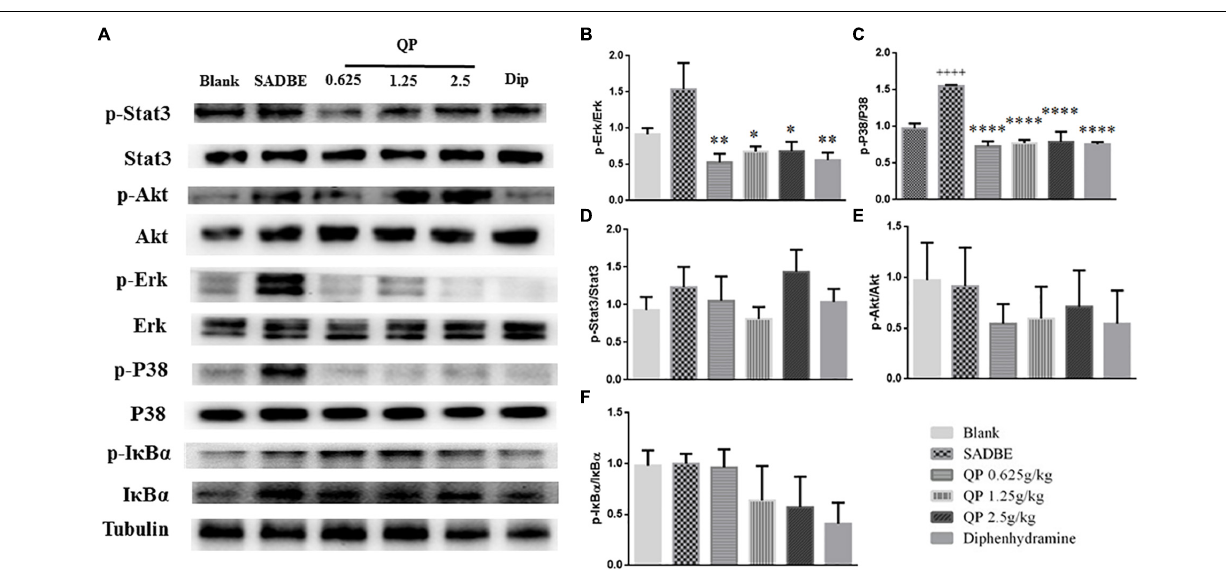
FIGURE 6 | QP suppressed the phosphorylation of MAPKs in the skin of SADBE mice. Representative western blots images of p-Stats, Stats, p-Akt, Akt, p-Erk, Erk, p-P38, p38, p-I κ B α , I κ B α , and Tubulin, respectively (A) . Expression of p-Erk (B) and p-P38 (C) but not p-Stat3 (D) , p-Akt (E) , and p-I κ B α (F) in the skin of SADBE mice was significantly reduced QP compared to that in the model group. Data was expressed as mean ± SEM. ∗ p < 0.05, ∗∗ p < 0.01, and ∗∗∗∗ p < 0.0001, compared to the model group. ++++ p < 0.0001, compared to the blank control group. ANOVA ( n = 3 each group). The related original western blot images were showed in Supplementary Figures S3, S4